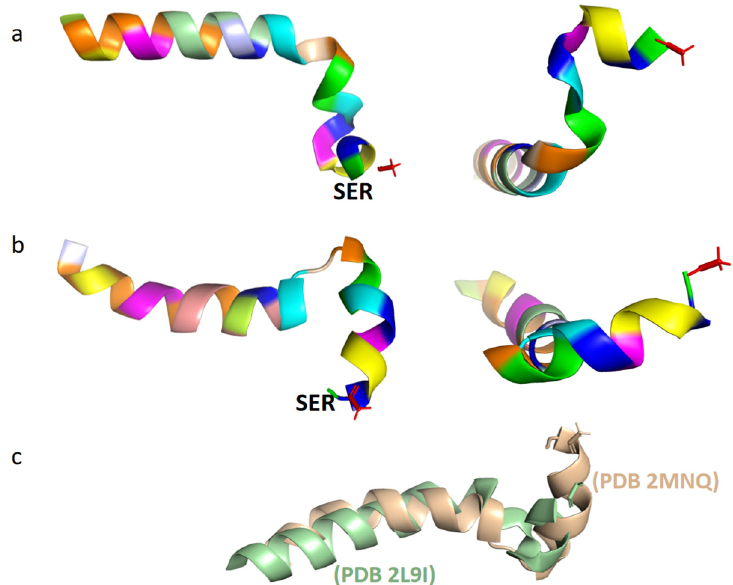
Figure 1. Tertiary structure of T α 1 in different solvents (analyzed and processed by the software of PyMOL 2.4.1). ( a ). Spatial conformation of T α 1 in a TFE mixed solvent (PDB 2L9I; Different colors represent different amino acids.). ( b ). Spatial conformation of T α 1 in an SDS micellar solvent (PDB 2MNQ; Different colors represent different amino acids.). ( c ). Details of the structural differences between T α 1 (in green) and SDS micelles (in brown) in a mixed solvent (obtained through superposition comparison of protein structures using the software of PyMOL 2.4.1).